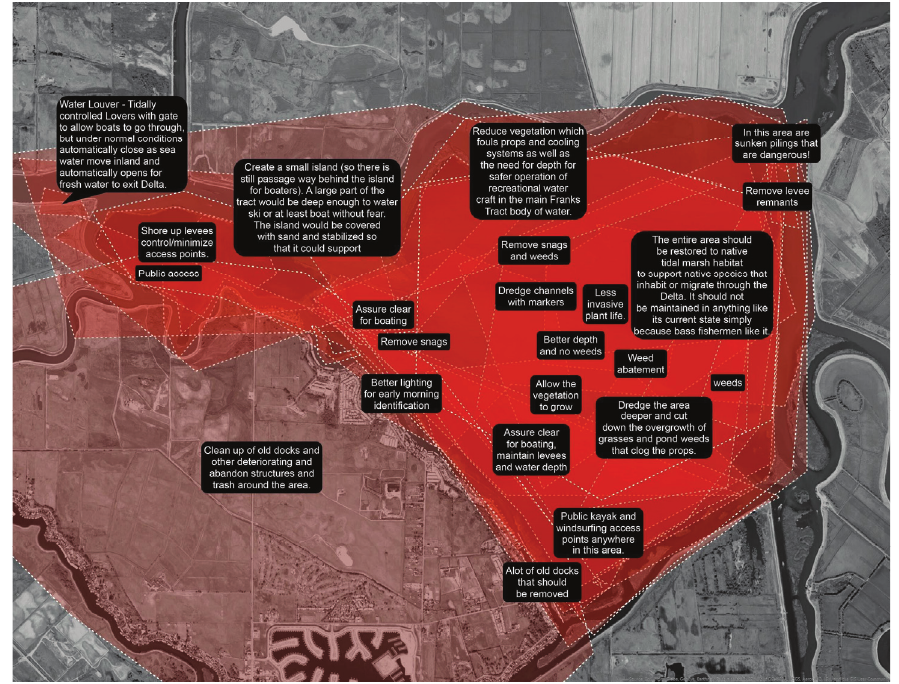
Figure 10. What are your regular boating routes across and within Franks Tract? Results indicate that Franks Tract is a major boating hub for both trips within Franks Tract as well navigation in the greater region. Results also reveal distinct tra ffi c flow patterns across and within Franks Tract